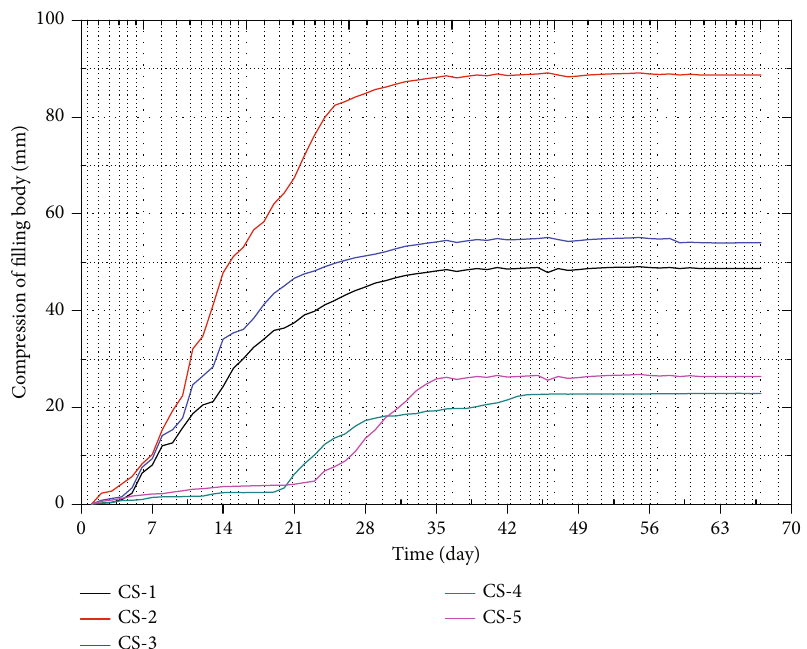
Figure 21: Compressive deformation of the paste back fi ll body vs. the curing